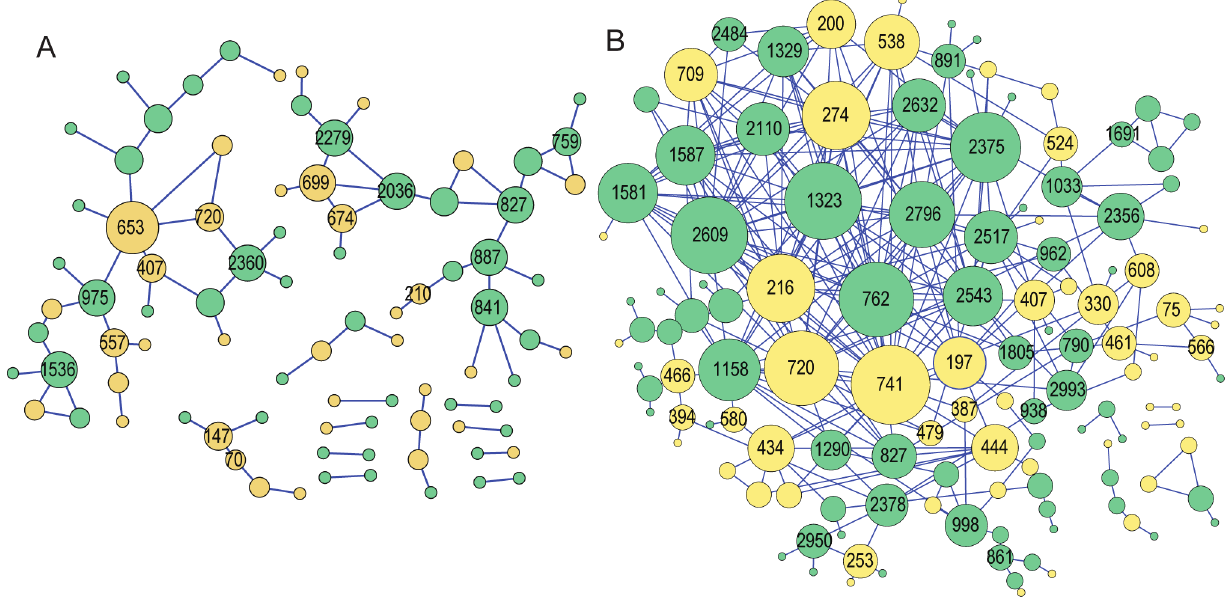
Figure 2. Amino acid covariance networks for the HCC and cirrhotic sequences. Amino acid covariances within alignments of the HCV cirrhotic (left) and HCC (right) sequences were graphed with the covarying positions (nodes) represented as circles and the covariances between the positions (edges) as lines. The size of the nodes is proportional to the number of edges that they contact. Yellow nodes are within structural proteins and green nodes are in non-structural proteins. The amino acid residue position numbered relative to the HCV polyprotein is indicated in the larger nodes.